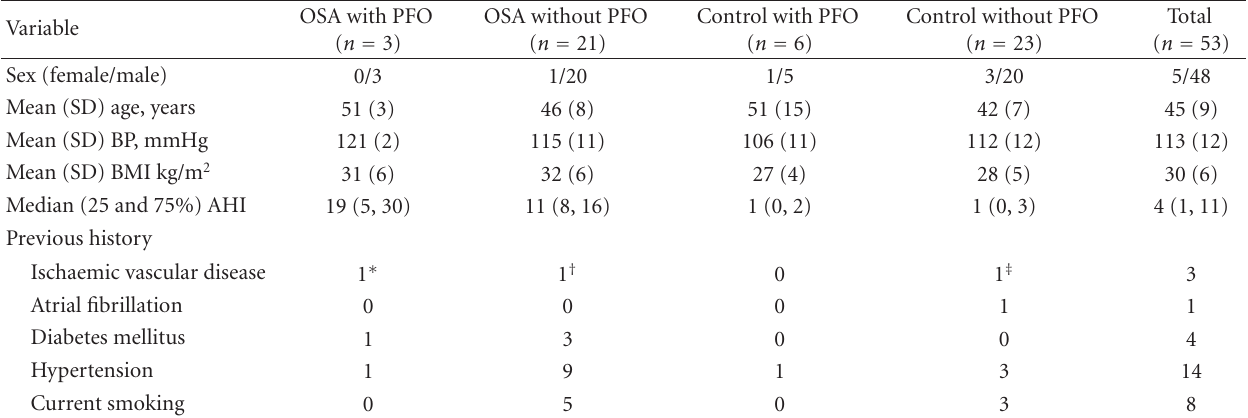
Table 1: Baseline characteristics of 53 subjects investigated for OSA and PFO.